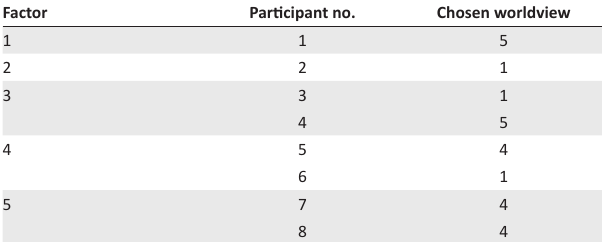
TABLE 2: Phase Four: Participants’ significant factors and chosen worldviews (as clarified in Table 1).